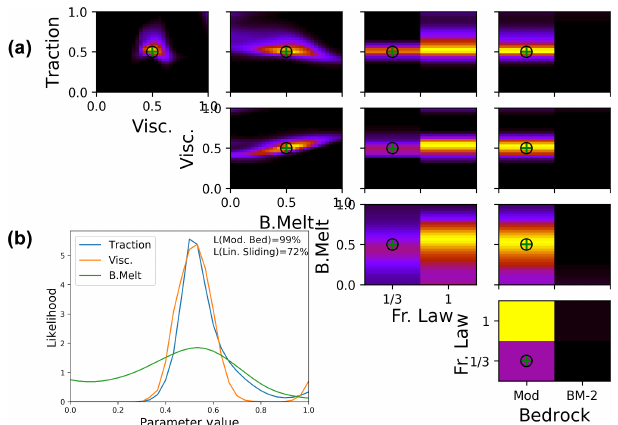
Figure 4. Likelihood of parameter combinations of the synthetic test case (evaluations of Eq. 12). Upper right panels show likelihood values marginalised to pairs of parameters including basal melt fac- tor (B. Melt) and friction law exponent (Fr. Law), normalised to the respective maximum for clarity. Lower left panel shows likelihood values marginalised to individual parameters for the three scalar parameters (line plots), as well as the friction law exponent and bedrock topography map (labelled as L(Lin. Sliding) and L(Mod. Bed) respectively), normalised to an integral of one, consistent with probability density functions. The central values for traction, vis- cosity, and ocean melt as well as non-linear friction and modified bedrock are used. The parameter values are also shown by the black circles, while the values of the set of parameters with highest likeli- hood are shown by green